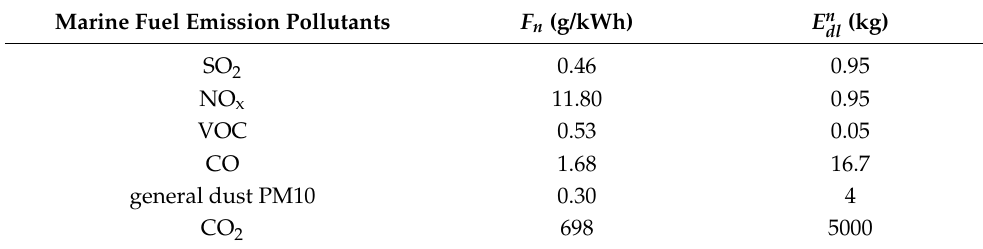
Table 1. Annual emission factors and pollution equivalent values of pollutants.